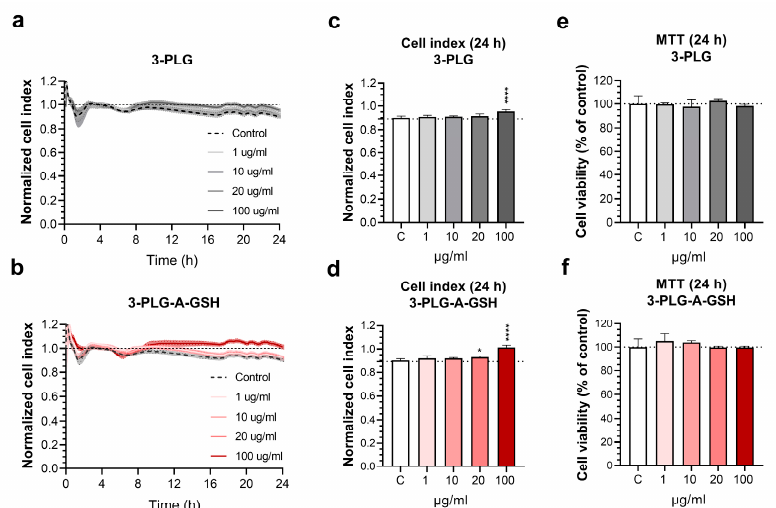
Figure 4. Effect of non-targeted (3-PLG) and alanine–glutathione-targeted (3-PLG-A-GSH) nanocarri- ers on the viability of human brain endothelial cells. Impedance kinetics of cell responses to ( a ) 3-PLG and ( b ) 3-PLG-A-GSH monitored for 24 h by real-time measurements. Impedance of human brain endothelial cells incubated with ( c ) 3-PLG and ( d ) 3-PLG-A-GSH at the 24-h time point. ( a – d ) Values presented are means ± SD and are given as cell index. Effect of ( e ) 3-PLG and ( f ) 3-PLG-A-GSH on the cell viability at 24 h measured by MTT test. Values presented are means ± SD and are given as a percentage of the control group. Statistical analysis: one-way ANOVA followed by Dunnett’s post-test; * p < 0.05, **** p < 0.0001, compared to the control group; n =